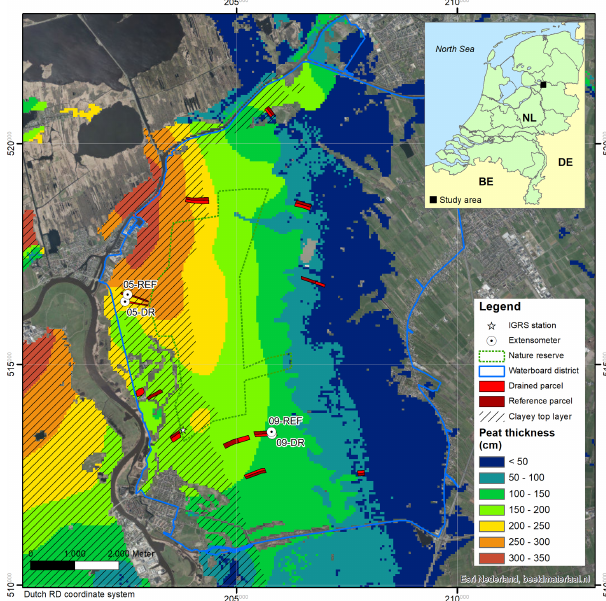
Figure 1. Study area with peat layer thickness (source: Waterboard Drents Overijselse Delta) and the location of measuring sites. In this paper results for sites 05 and 09 are presented (DR = drained, REF = reference